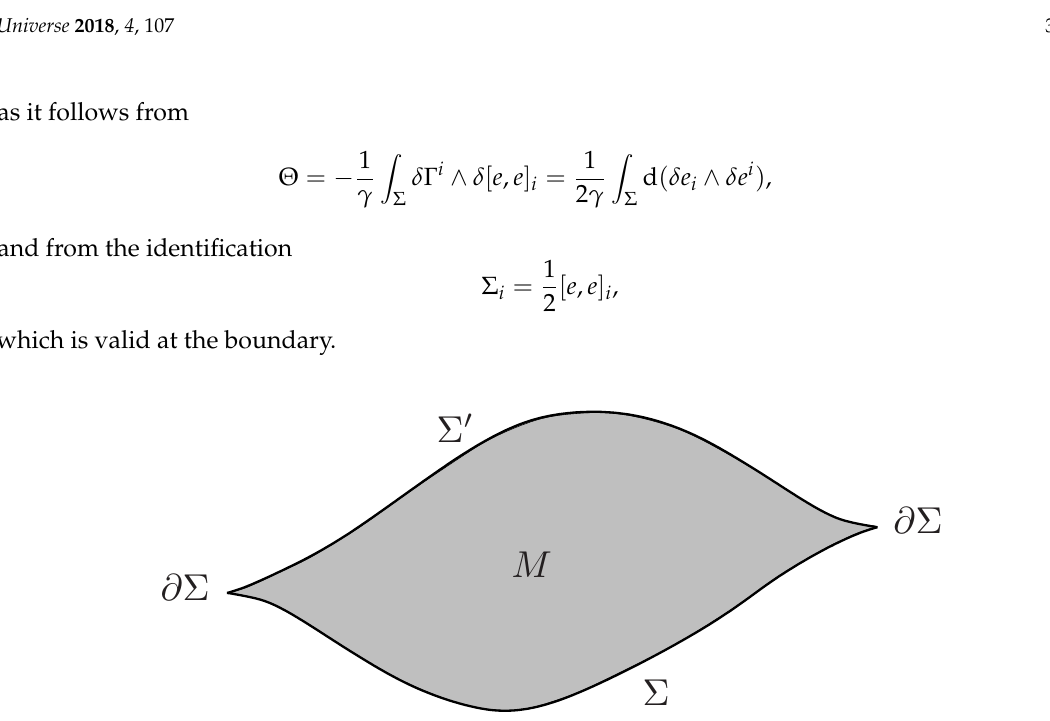
Figure 1. Spacetime region obtained from the time flow that is allowed in our analysis. Lapse and shift are constrained on the corners ∂ Σ in order to preserve the boundary fixed up to tangent diffeomorphisms and gauge transformations.